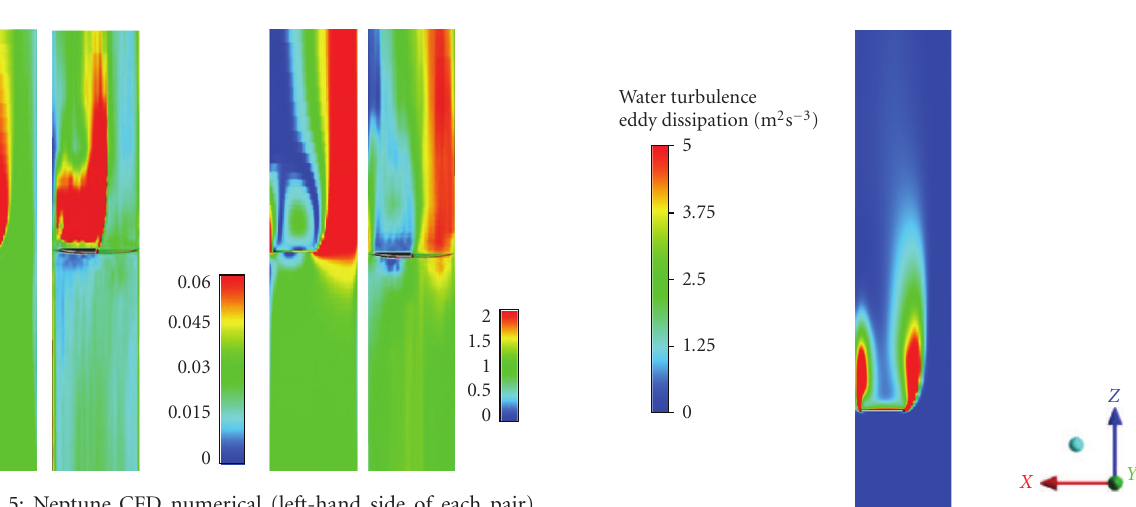
Figure 5: Neptune CFD numerical (left-hand side of each pair) versus TOPFLOW experimental (right-hand side of each pair) results for run 074. The two left-hand side pictures represent the dispersed phase volume fraction (scale from 0 to 6 · 10 − 2 ) across the symmetry plane of the pipe and the two right-hand side pictures the liquid velocity norm (scale from 0 to 2ms − 1 ).